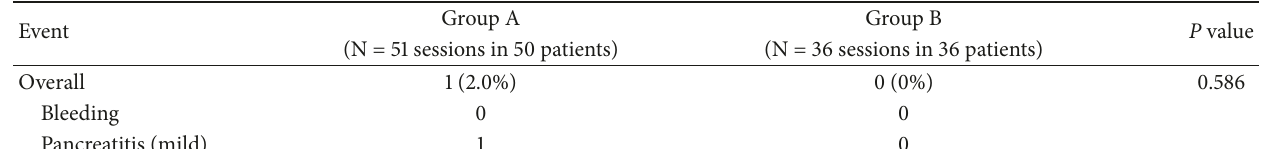
Table 4: Adverse events.